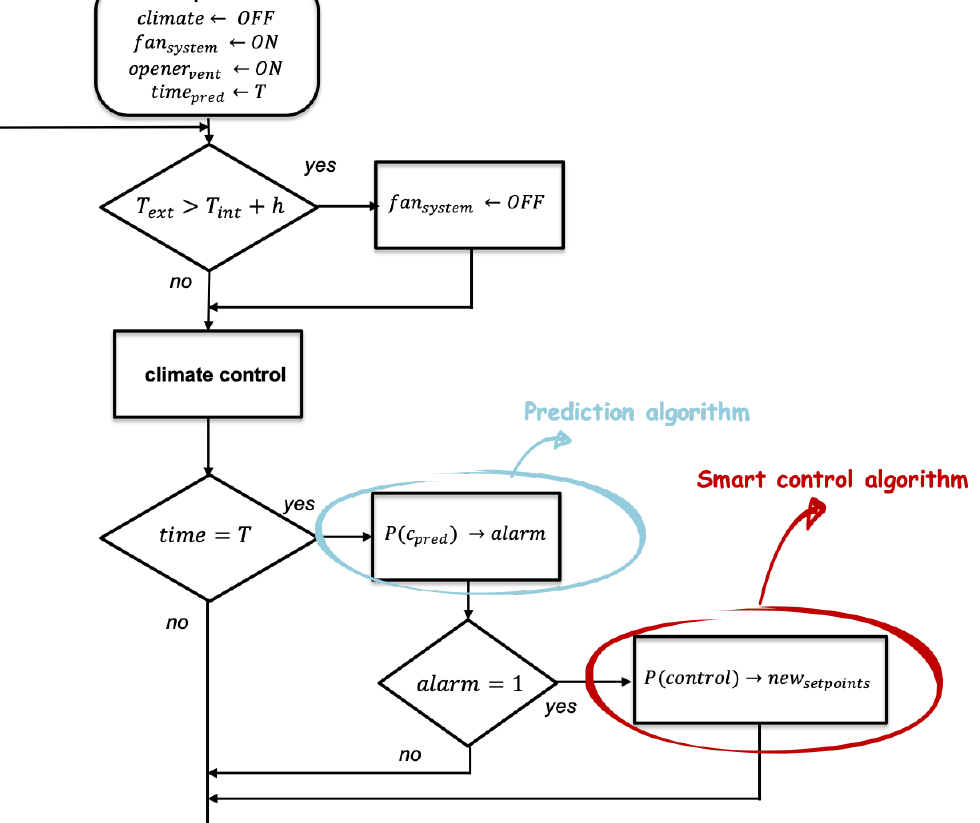
Figure 4. Prediction integration and smart control algorithms in the experimental smart greenhouse